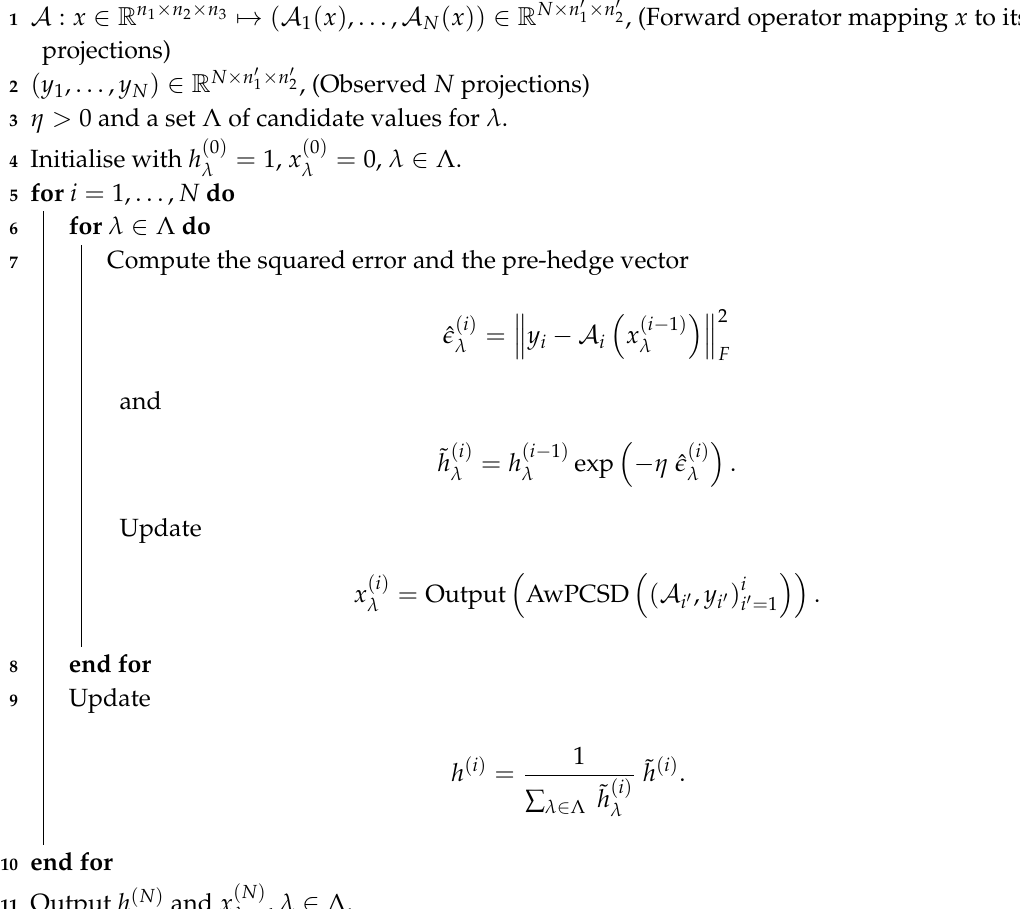
Algorithm 2: Hedge based λ